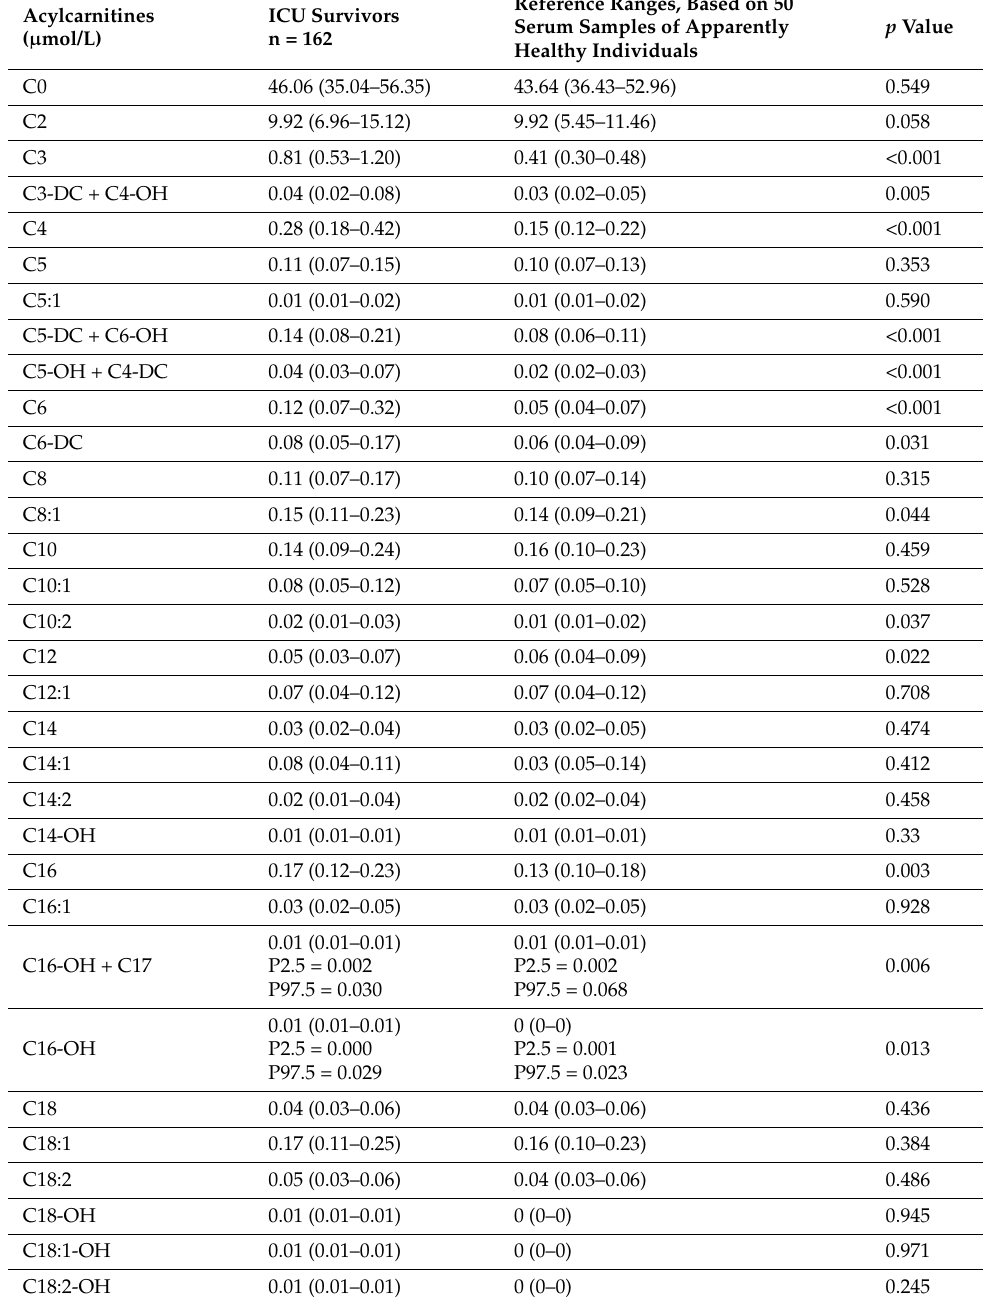
Table 2. Acylcarnitines concentration in ICU survivors and in the reference population. Acylcarnitines ( µ